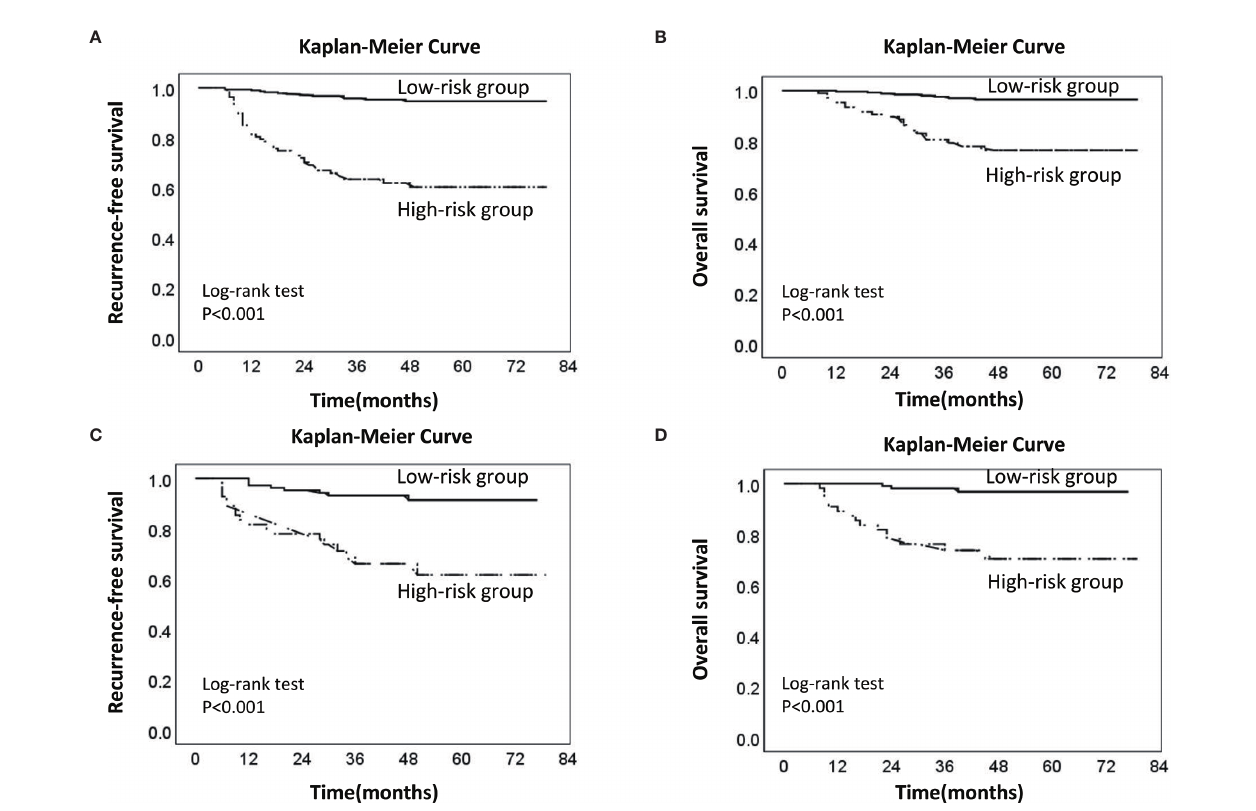
FIGURE 5 | Kaplan-Meier survival curve of the low-risk and high-risk groups of LNM. (A) Recurrence-free survival curve of the low-risk and high-risk groups in the training cohort; (B) Overall survival curve of the low-risk and high-risk groups in the training cohort. (C) Recurrence-free survival curve of the low-risk and high-risk groups in the validation cohort. (D) Overall survival curve of the low-risk and high-risk groups in the validation cohort (the dotted line: High-risk group; the solid line: Low-risk